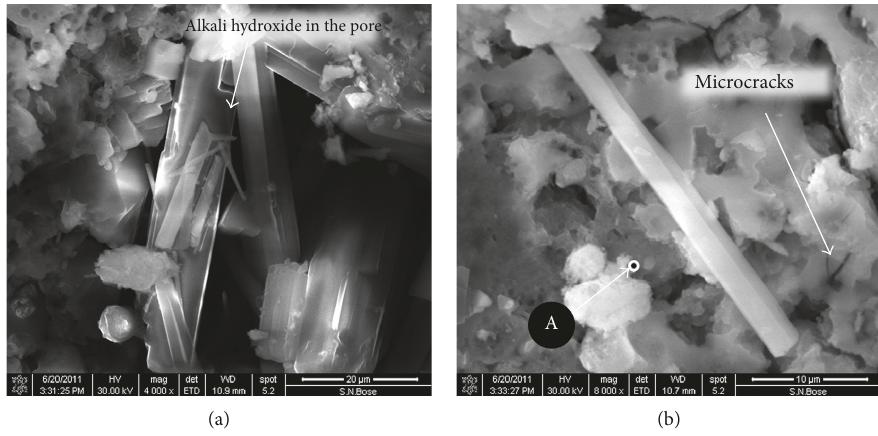
Figure 4: (a) Crystal structure within SMF1. (b) After fatigue exposure, microcracks in SMF1.